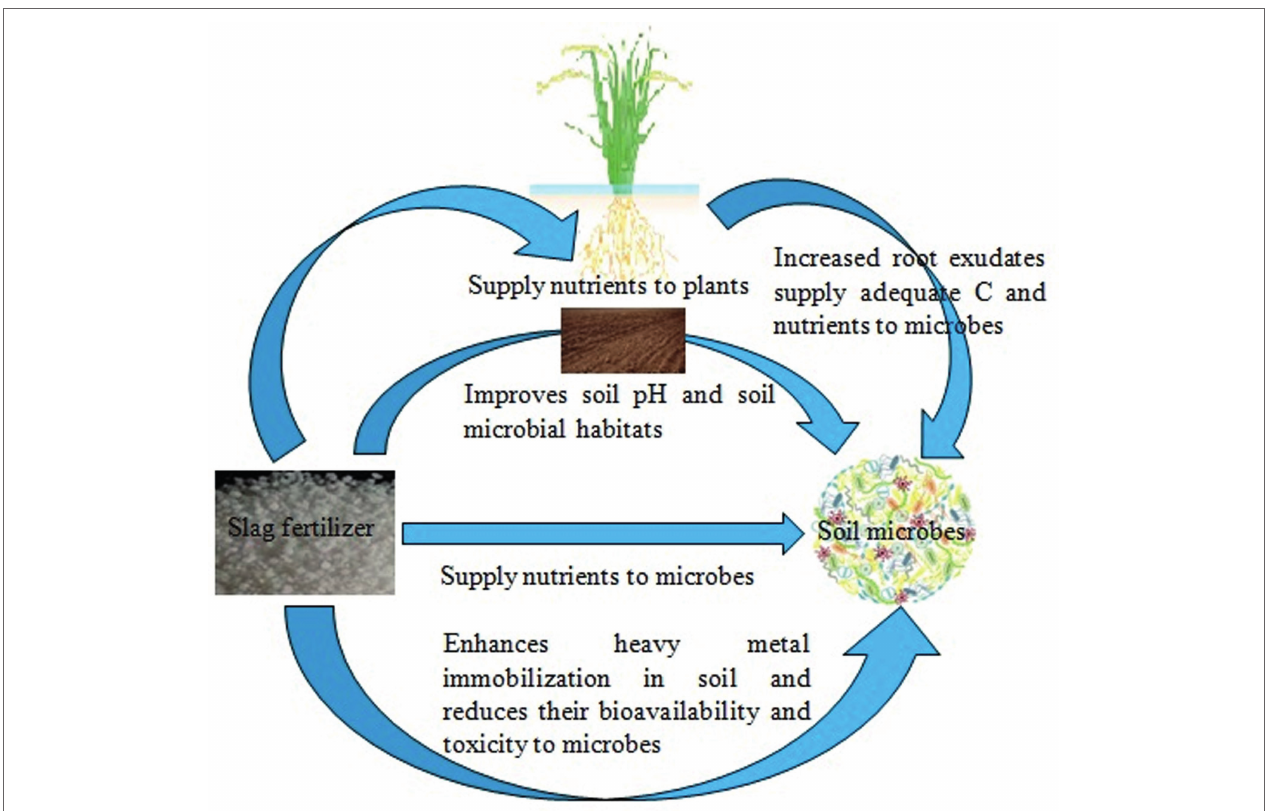
FIGURE 1 | The proposed mechanism of slag-microbe interactions in